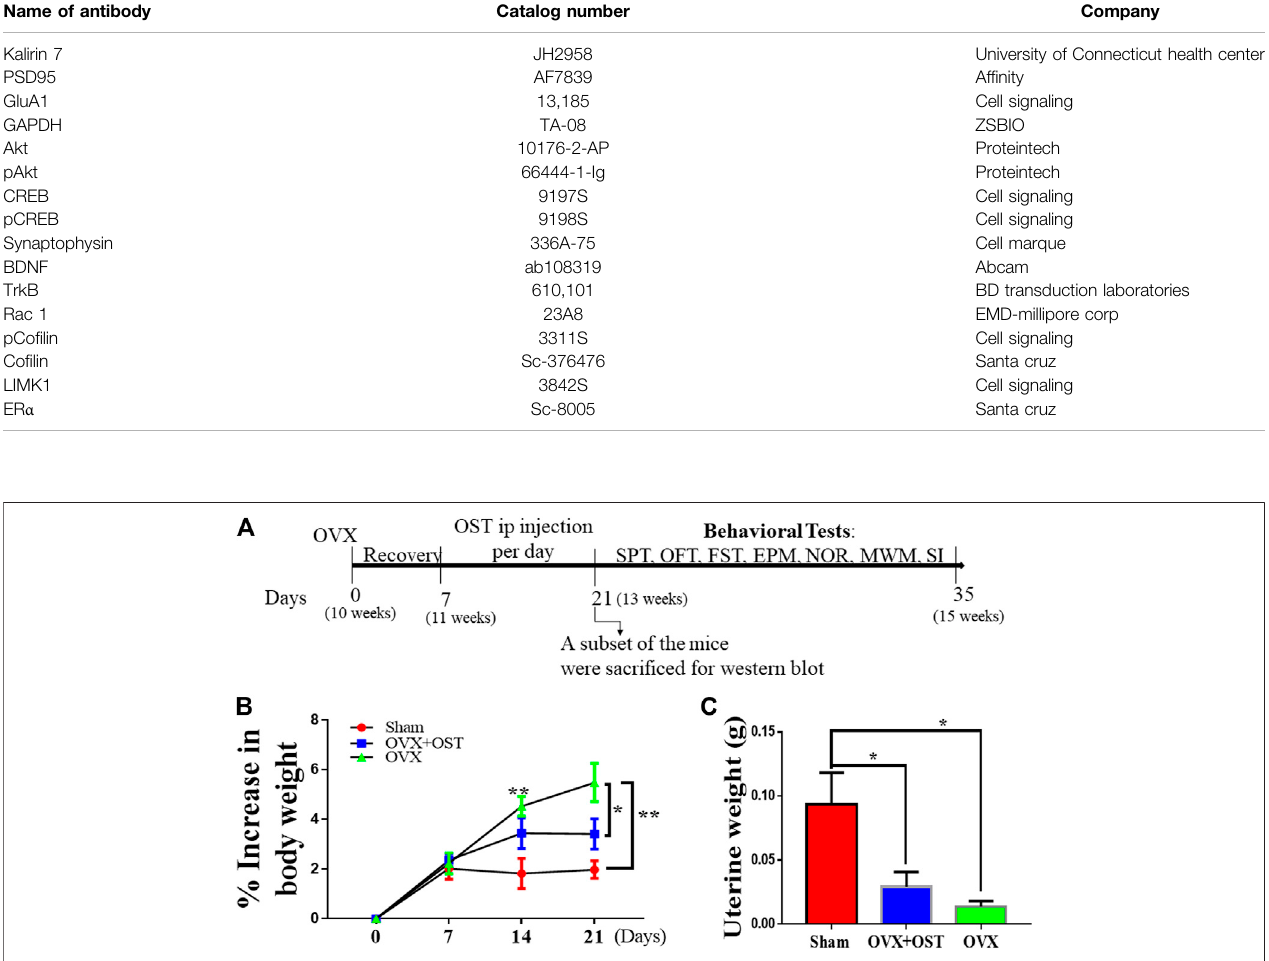
FIGURE 1 | Experimental design (A) OVX – ovariectomy; i. p – intraperitoneal; SPT – sucrose preference test; OFT – open fi eld test; FST – forced swim test; EPM – elevated plus maze; NOR – novel object recognition; MWM-Morris Water Maze; SI – social interaction. The age of the mice is shown in brackets. (B) The effect of OST on body weight in Sham, OVX, and OVX + OST mice. Body weight gain is shown as percentage of baseline control at day 0 for the different groups at each week. OVX induced a signi fi cant increase in body weight gain compared to the sham group, and OST treatment was able to reverse this increase induced by OVX. (C) OVX induced a signi fi cant decrease in uterine weight compared to the sham. Treatment with OST was unable to reverse this decrease. Data are represented as mean ± SEM (body weight n (cid:1) 20, uterine weight, n (cid:1) 5). * p < 0.05, ** p < 0.01 vs